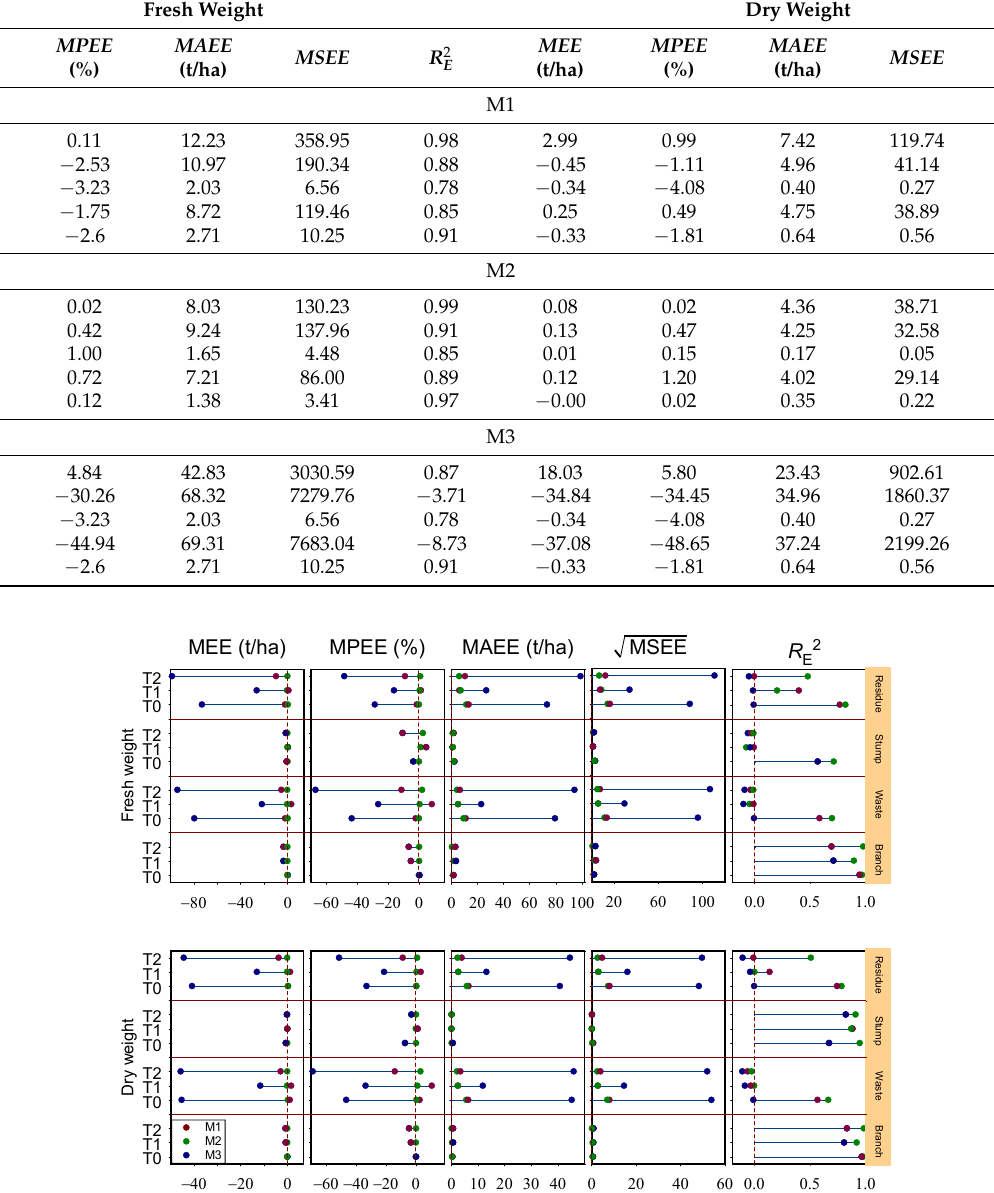
Figure 10. Dot plots displaying five benchmarking statistics for indirect validation of residue biomass estimates in fresh and dry weight (upper and lower halves) that were obtained through harvester data analytics for three types of stands: unthinned (T0), thinned once (T1), and thinned twice (T2). Total residue biomass is labelled as ‘Residue’ in the yellow strip at the right end of each graph. M1, M2, and M3 in the legend represent the first, second, and third method of residue biomass calculation used in data analytics (see text). Due to space limitations, dot points showing (cid:1844) (cid:3006)(cid:2870) < 0 were indicative only, and do not represent the actual values. Table 2. Benchmarking statistics for the three methods of residue biomass estimation for all stand types combined.